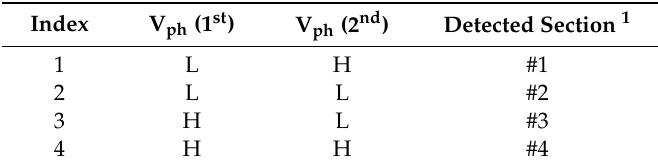
Figure 5. Example of defining impedance sections: ( a ) Simulation result of V ph ; ( b ) resultant impedance sections. (Assuming that | Γ L | is determined by voltage standing wave ratio (VSWR, | Γ L | ) detector). Table 1. Example of detecting section from V ph value set. (Figure 5a).